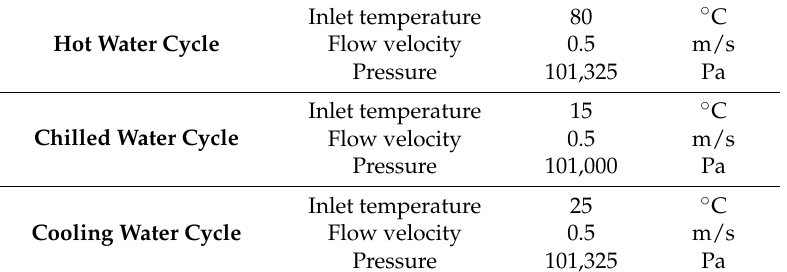
Table 5. Temperature data-3.